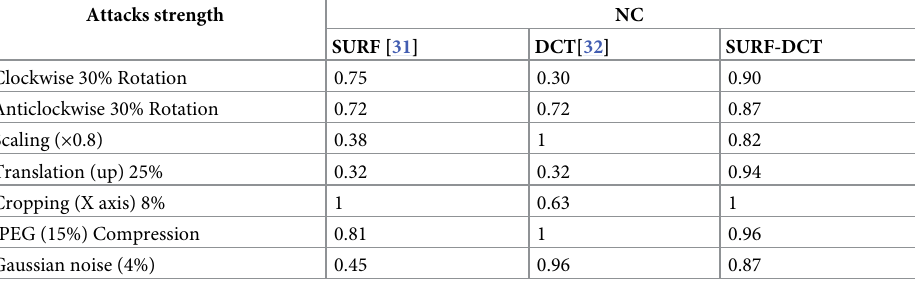
Table 4. Proposed algorithm comparison with SURF and